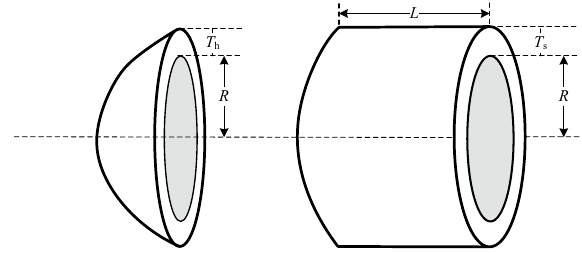
Figure 14. Pressure vessel design.